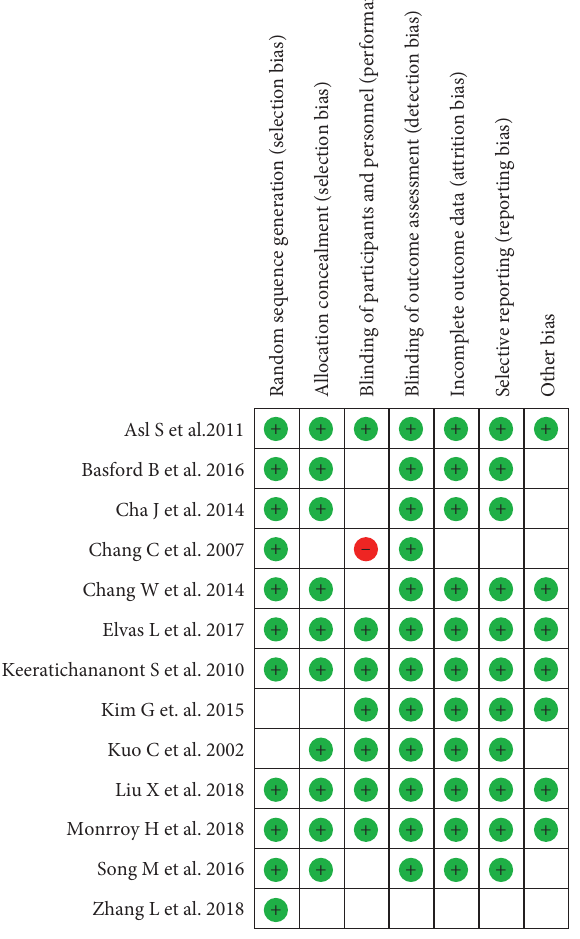
Figure 2: Risk of bias summary: review authors’ judgments about each risk of bias item for each included study. The green circle indicates low risk of bias, the red circle indicates high risk, and a blank box indicates unclear